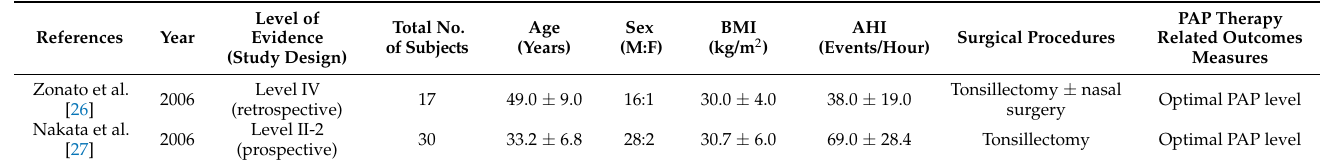
Table 1. Characteristics of the included